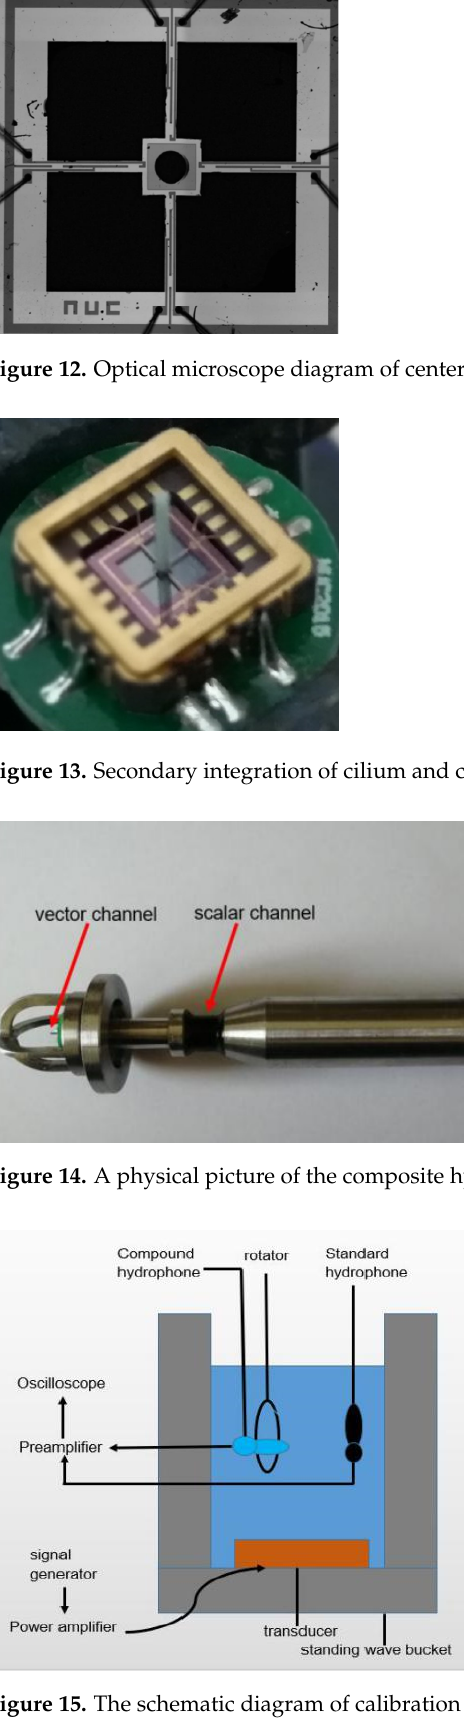
Figure 15. The schematic diagram of calibration system.